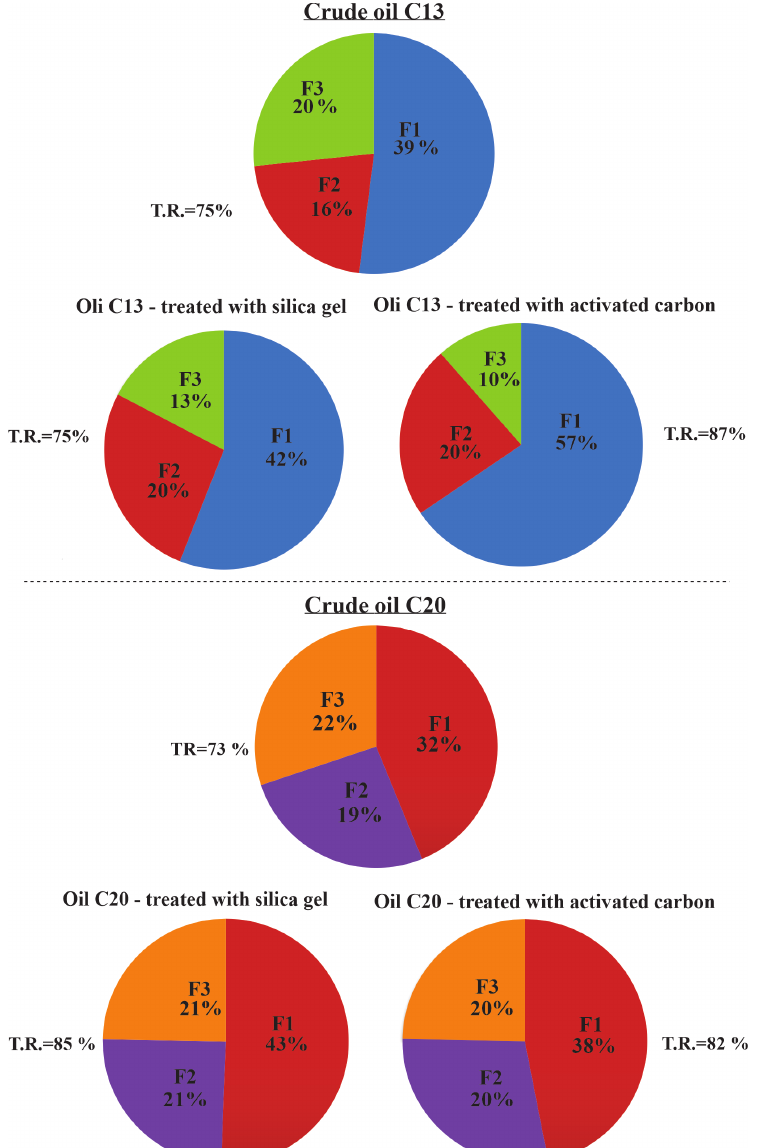
Figure 7. F1 (saturate), F2 (aromatic) and F3 (NSO) fractions obtained by classic liquid chromatographic separation. Note: TR= total